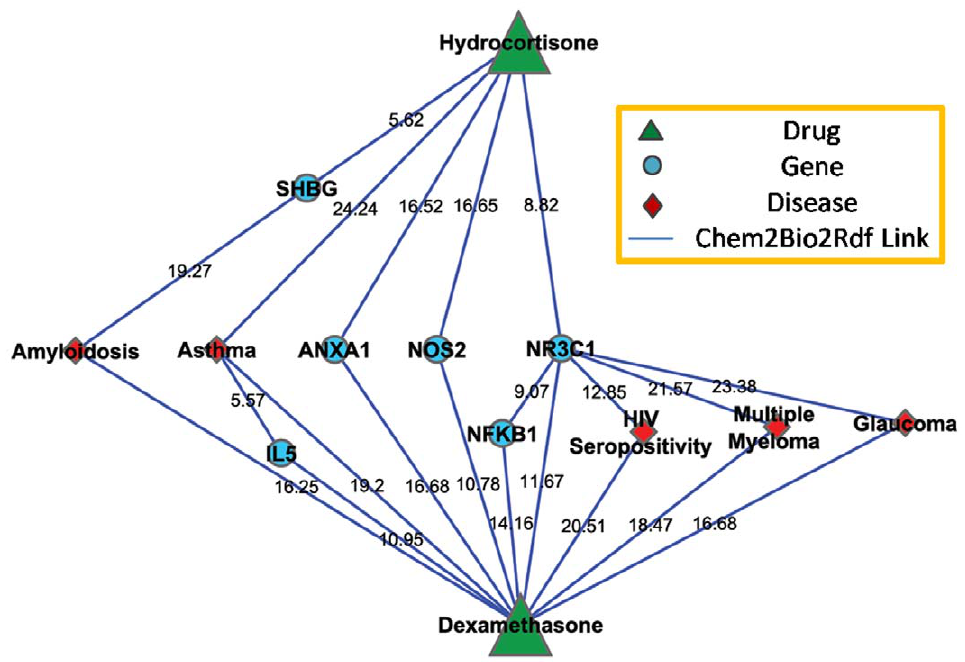
Figure 7. The top 10 paths obtained between Hydrocortisone and Dexamethasone.